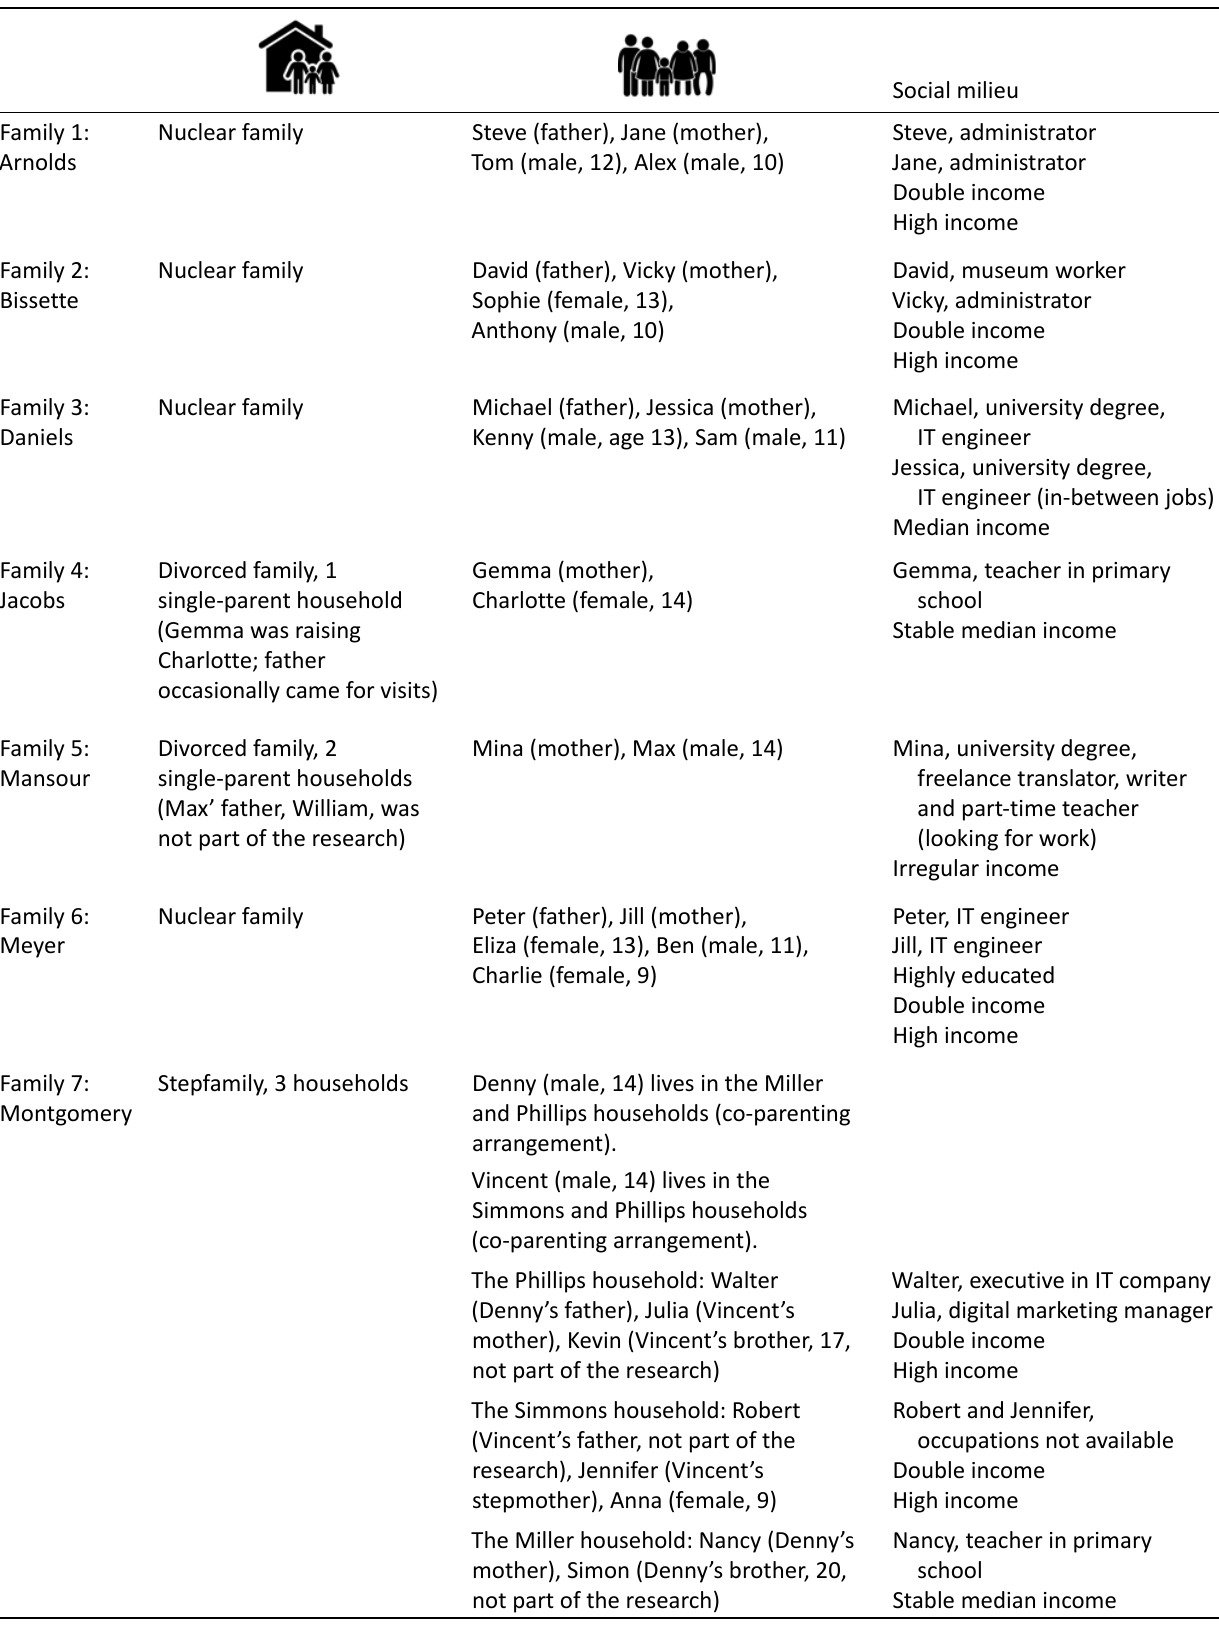
Table 1. Overview of